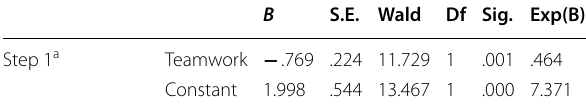
Table A2: Variables in the equation for a teamwork